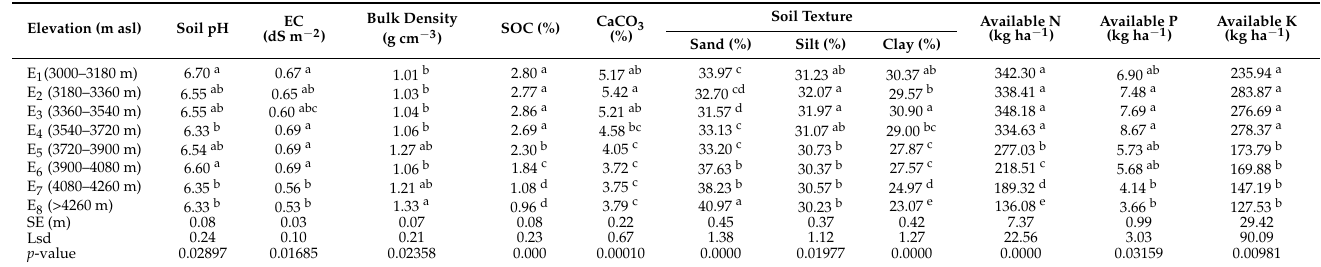
Table 2. Soil physico-chemical characteristics at a different elevation in the cold desert of north- western